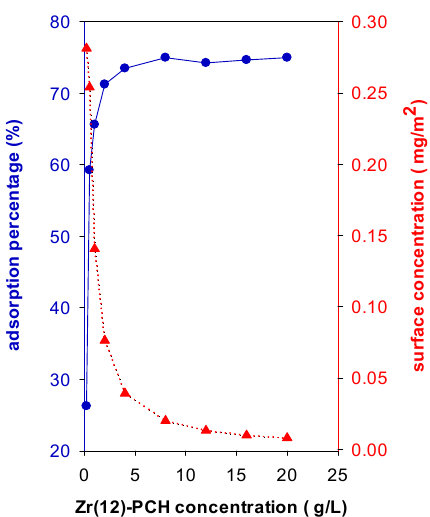
Figure 7. Effect of Zr(12) ‐ PCH concentration (g/L) on the adsorption percentage of (R%) ( ● ) and on the surface concentration (mg/m 2 ) ( ▲ ) of Basic Blue ‐ 41 adsorption.